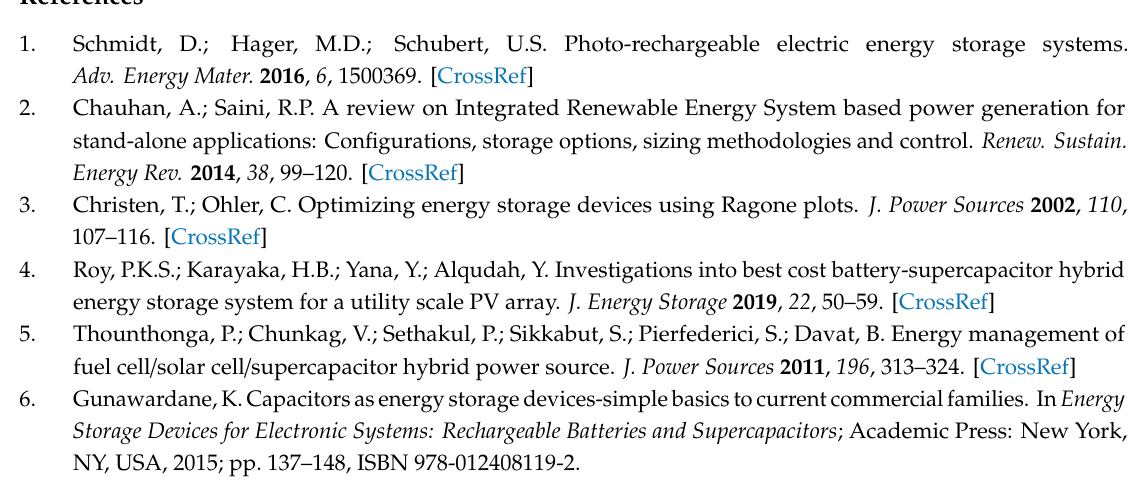
Figure S1: I-V characteristics of: (a) PV cell with size of 50 mm × 20 mm and (b) PV module with size of 65 mm × 65 mm; Figure S2: Schematic diagrams of PV panels: (a) photovoltaic cells in a 2 × 10 × 4